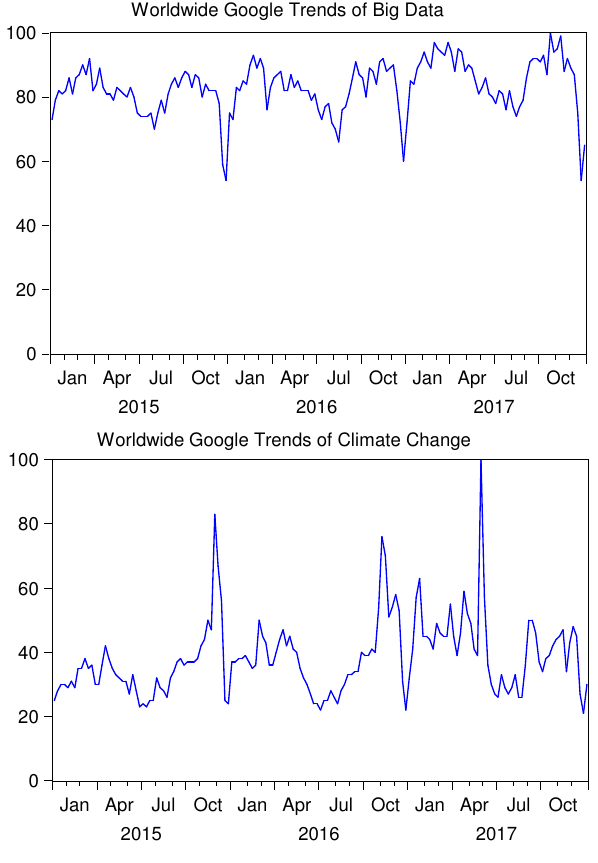
Figure 2. Google Trends index of big data and climate change since